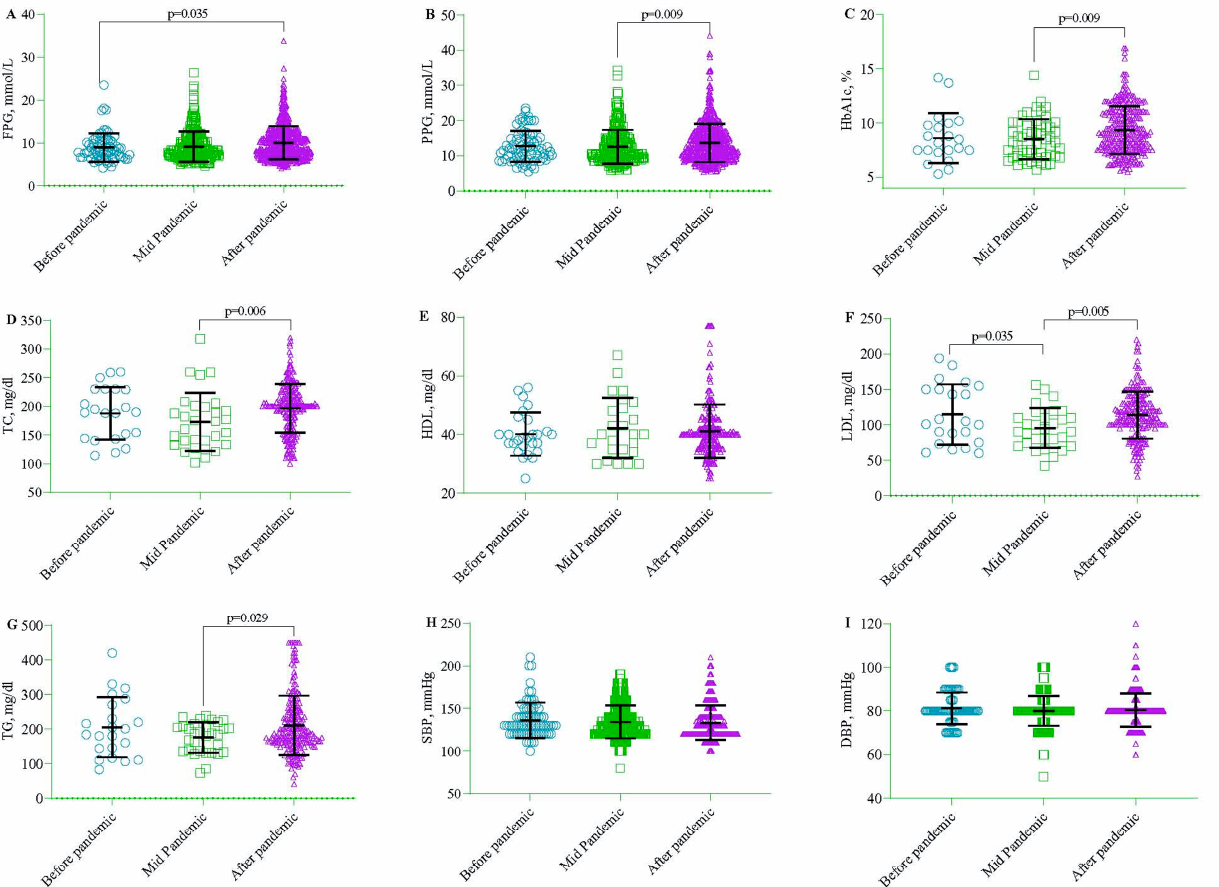
Figure 1. Key diabetic, lipids, and cardiometabolic markers in different periods of the COVID-19 pandemic. FPG = fasting plasma glucose levels ( A ); PPG = post prandial plasma glucose ( B ); HbA1c% ( C ); TC = total cholesterol ( D ); HDL = high-density lipoprotein ( E ); LDL = low-density lipoprotein ( F ); TG = triglyceride ( G ); SBP = systolic blood pressure ( H ); DBP = diastolic blood pressure ( I ).